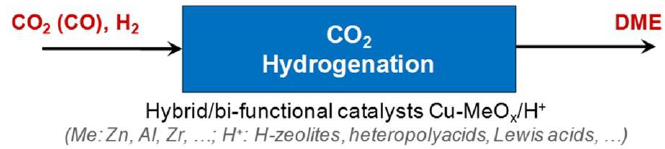
Figure 9. Scheme of the direct synthesis of DME through CO 2 hydrogenation.